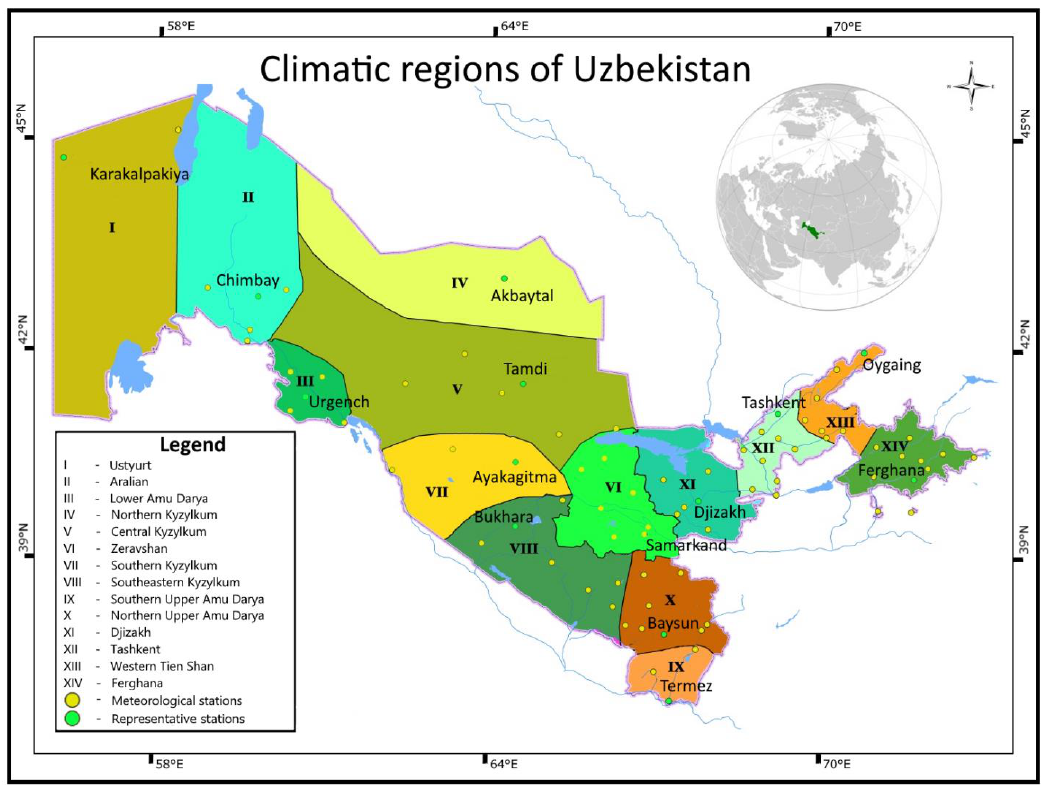
Figure 1. Climatic regions of Uzbekistan and the distribution of meteorological observation stations. The daily data from the UzHydromet published handbook “Calendar of Synoptic Weather Types of Middle Asia” [18,19] were used to assess changes in the statistical characteristics of SWT duration in Middle Asia. Statistical characteristics of SWT duration for the baseline climate period were taken